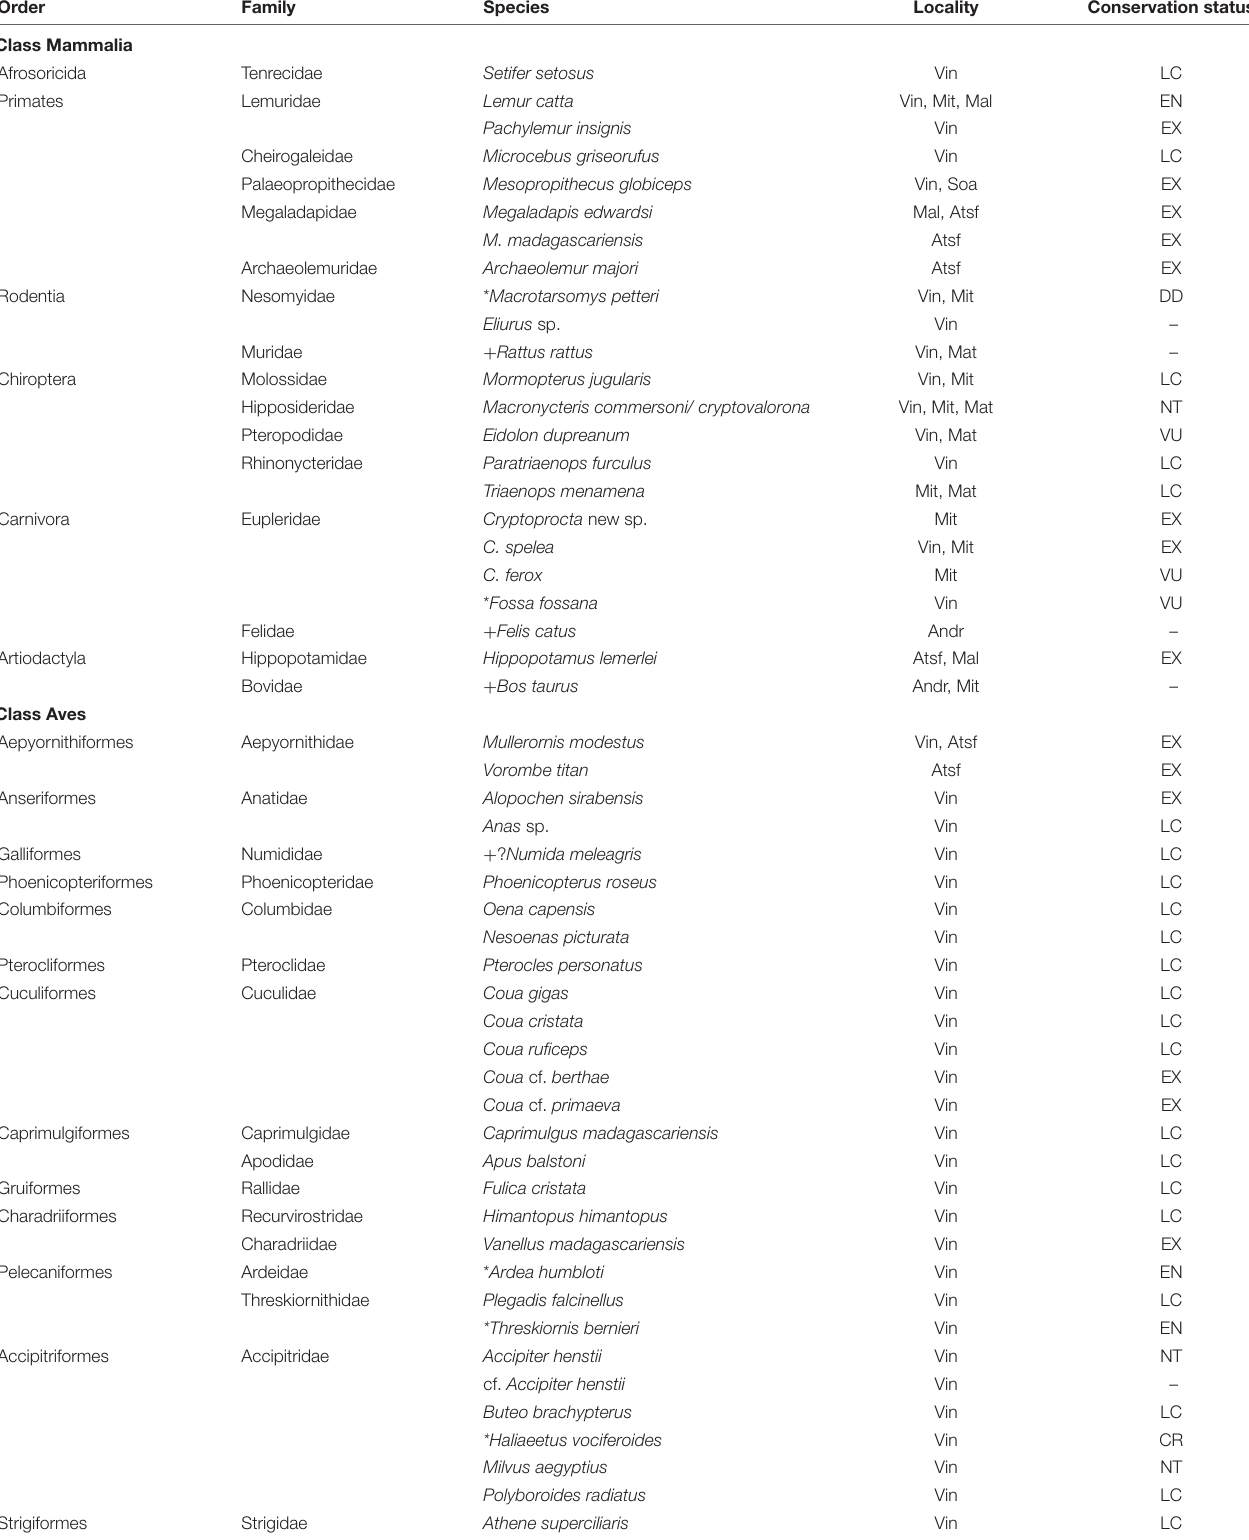
TABLE 2 | Vertebrate taxa found in subfossil deposits at Tsimanampesotse and/or region of Antsirafaly.